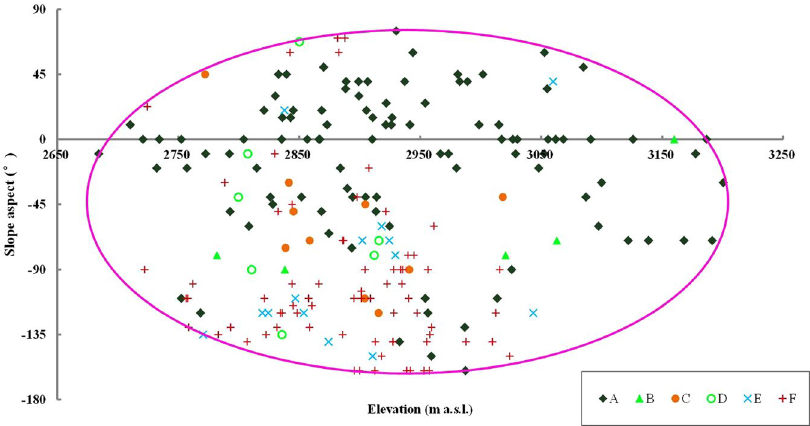
Figure 5. Composition of vegetated units of all vegetation types within the potential distribution area of Qinghai spruce forests. This map was generated using Microsoft Excel 2010